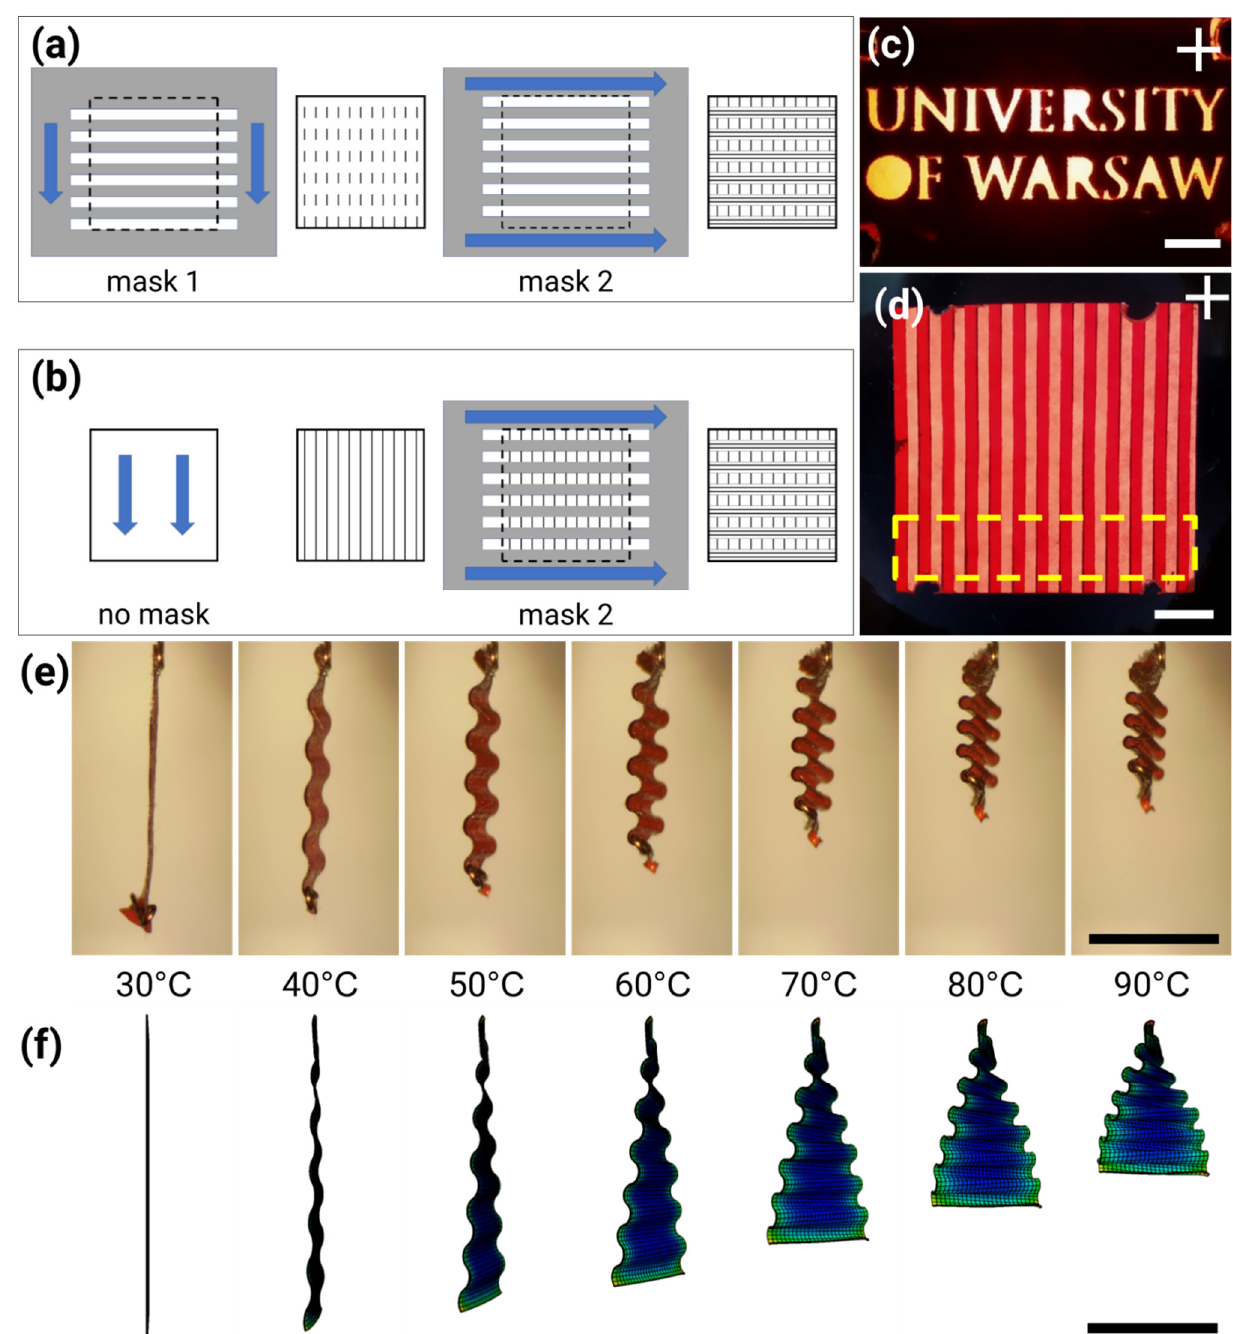
Figure 1. Two approaches to the fabrication of LCE films with patterned orientation. In the previously used method, two masks (grey) were used, one for each rubbing direction (indicated by blue arrows and grey lines) ( a ). In the rubbing overwriting method, the entire surface is rubbed in one direction first and one mask is used for the regions with a perpendicular rubbing direction ( b ). ( c , d ) LCE films prepared with rubbing overwriting technique using: ( c ) a mask with the University of Warsaw logo cut out and ( d ) a mask with 1 mm wide slits cut out. The yellow box shows how the accordion-like actuator was cut from the film. White light photographs were taken between crossed polarizers, with the white cross showing the orientation of the polarizers. ( e ) Accordion-like deformation in a stripe of LCE film cut perpendicular to the pattern lines, heated from 30 °C to 90 °C. ( f ) Finite element simulation of the LCE stripe deformation. Temperature values relate to conditions in ( e – f ). All scale bars are 5 mm long.